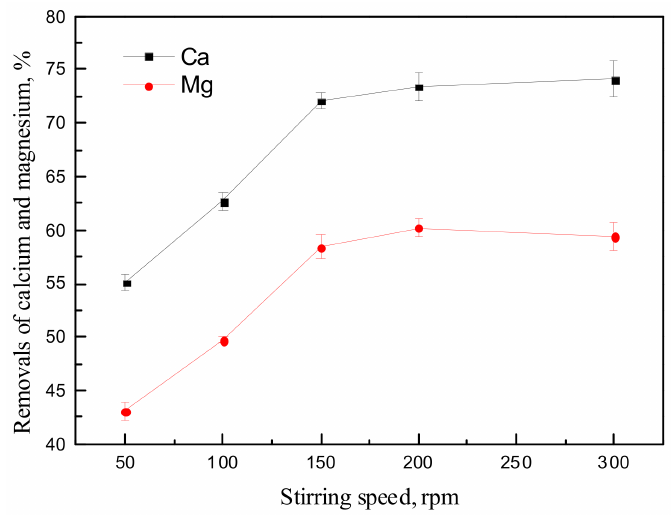
Figure 6. Effect of stirring speed on the calcium and magnesium removals.